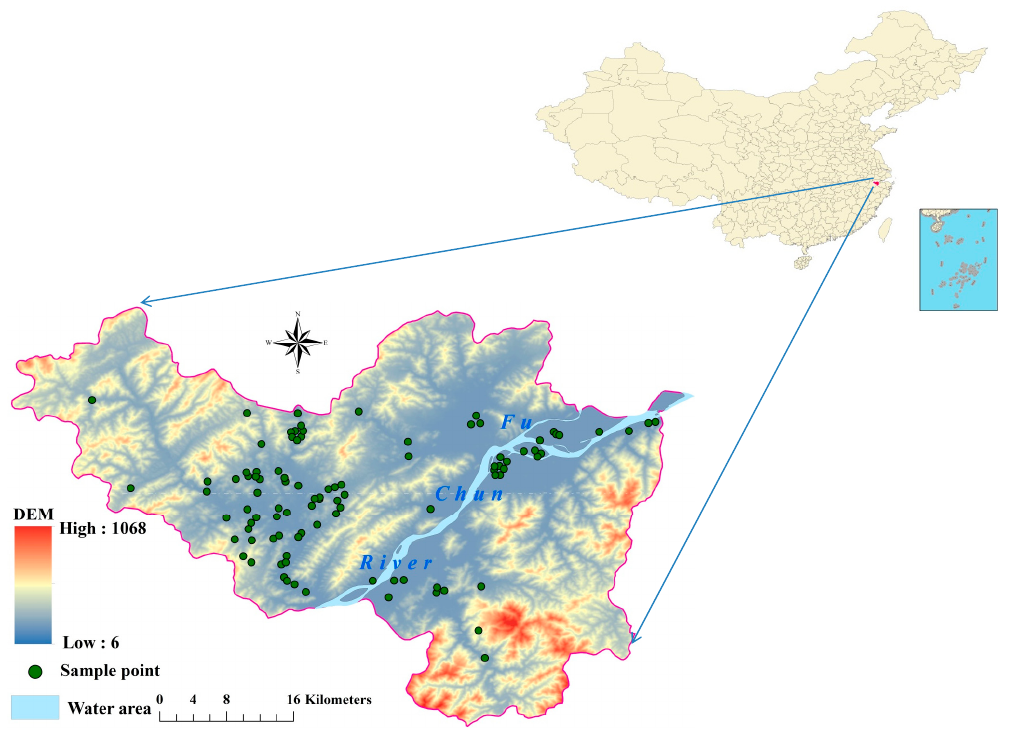
Figure 1. Location of samples in study area.